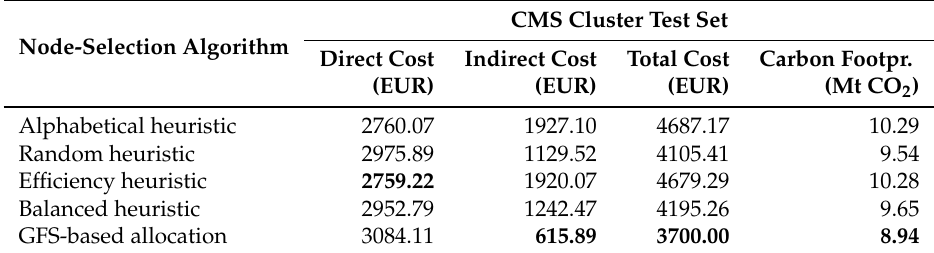
Table 7. Experiment results for the test set of the CMS cluster